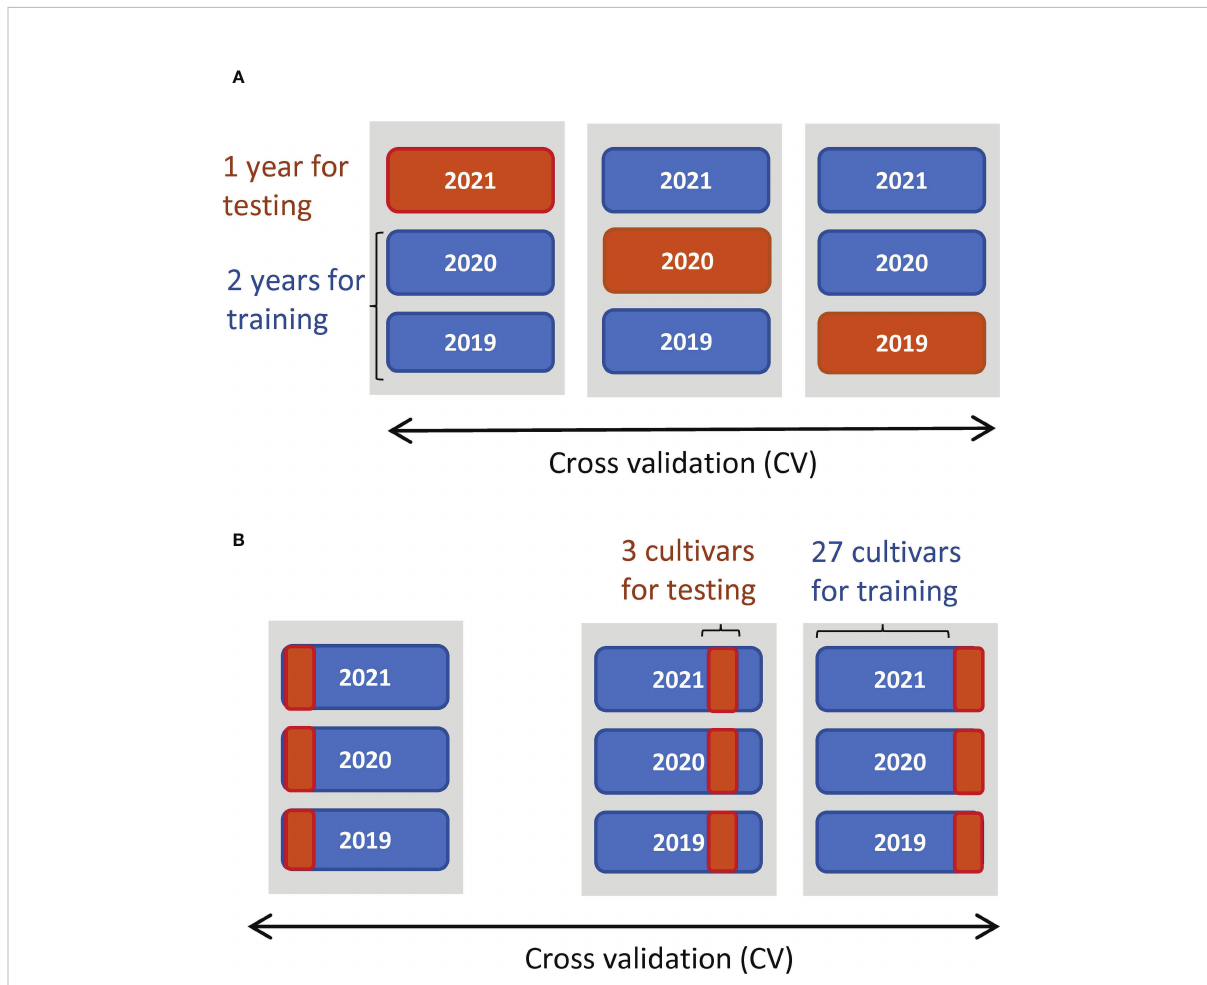
FIGURE 3 Schemes of CV to predict manually measured traits. (A) Threefold CV, where data were split by year: two years were used for training data and the other as test data. (B) Tenfold CV, where data were split by cultivar: 27 cultivars as training data and the other 3 as test